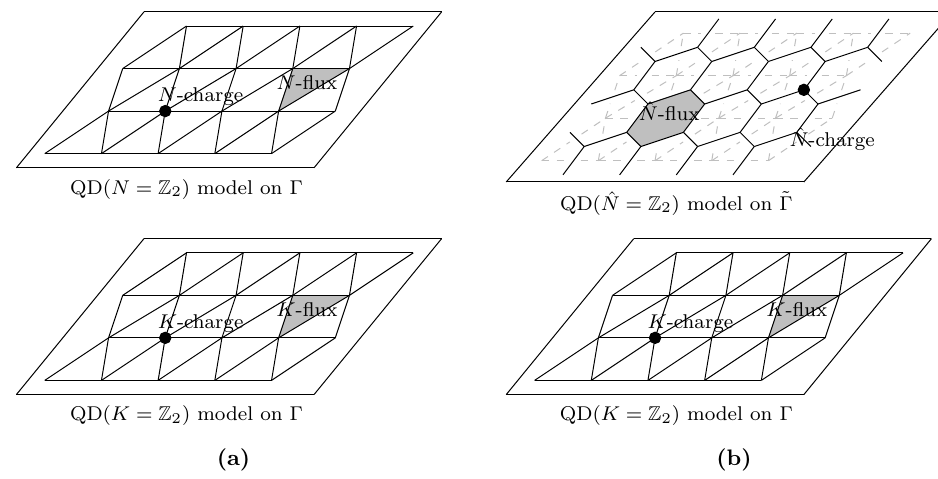
Figure 5 . (a) The QD ( Z 4 ) model can be understood as a bilayer system. The both layers are QD ( Z 2 ) models on Γ . (b) The TQD ( Z 2 × Z 2 ) model can be understood as a bilayer system. On the upper layer is a QD ( Z 2 ) model On Γ , while on the lower layer a QD ( Z 2 ) models on ˜Γ